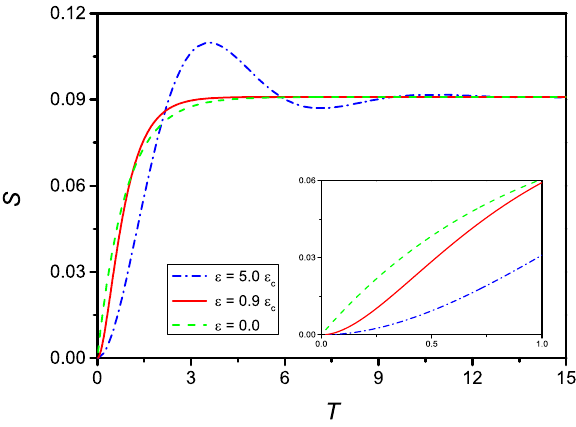
Figure 7. Time evolution (in dimensionless units) of S for ε = 5 ε c (dash-dotted), ε = 0.9 ε c (full), and δ = 0 (dashed), with u = 0.1. From the inset, where it is reported the evolution for small T , it is evident that in the case ε = 0 the initial boundary condition on dS / dT is not satisfied, as a consequence from the fact that in this case the differential equation passes from the second to the first